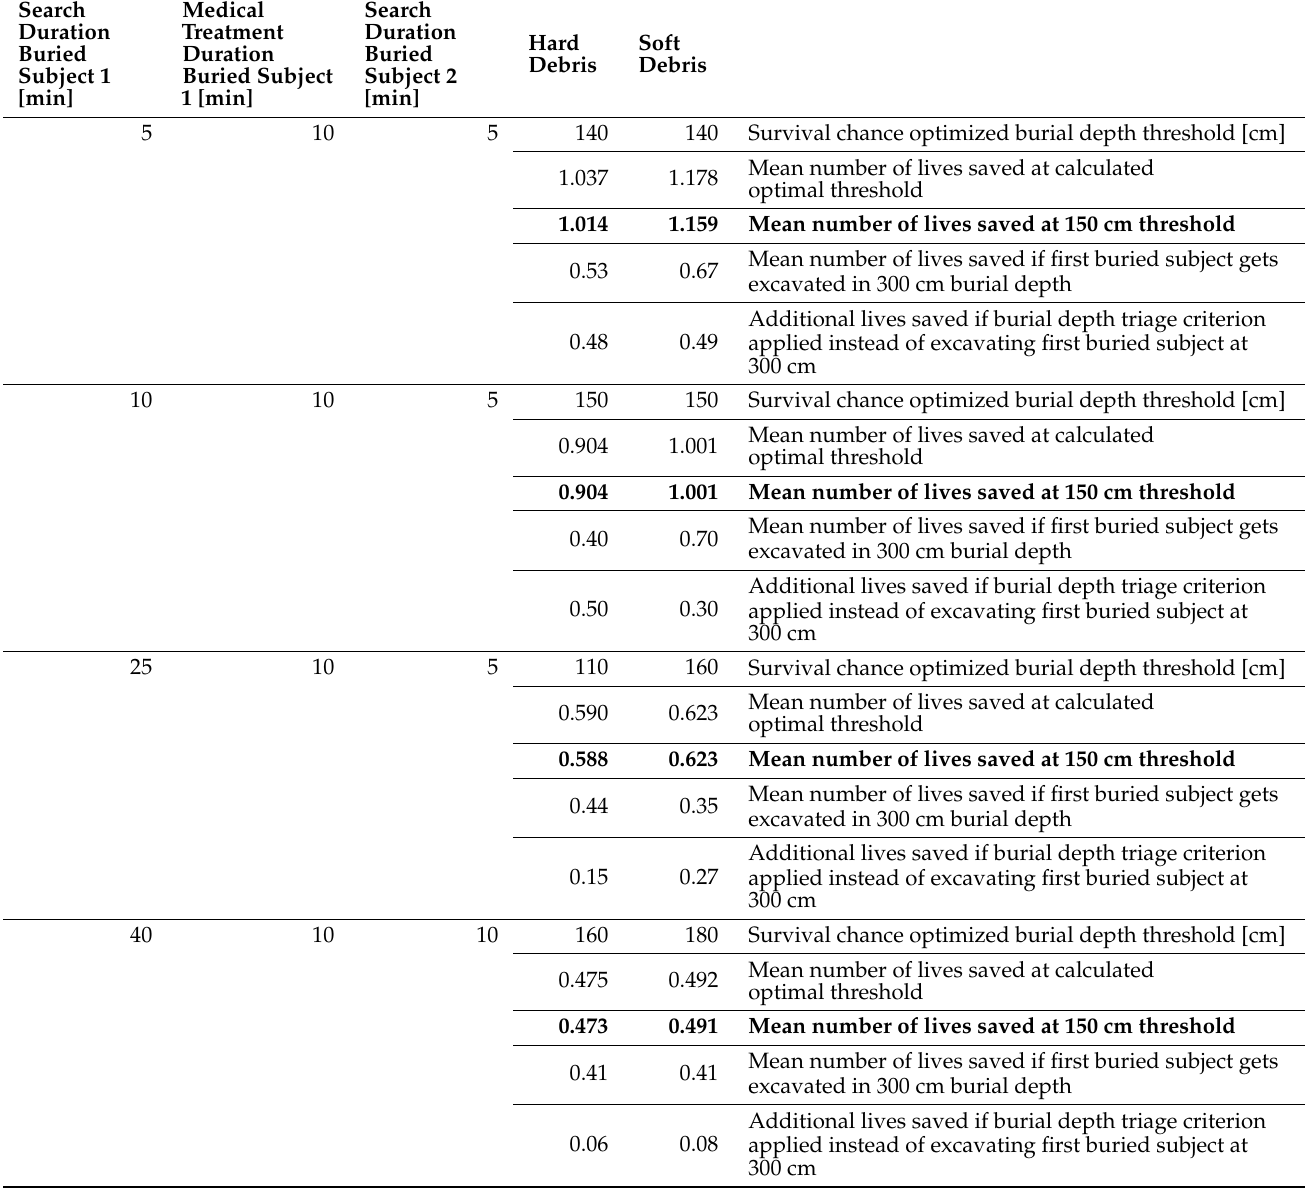
Table 1. Burial depth threshold and mean number of lives